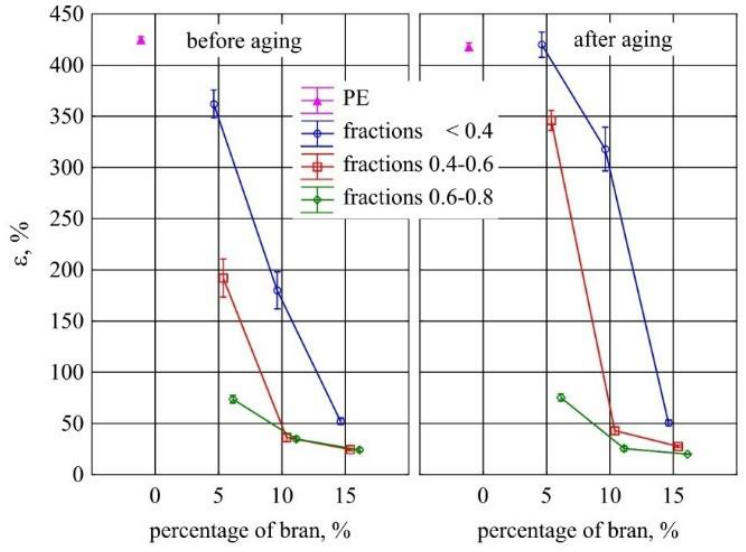
Figure 23. Elongation at break of injection mouldings before and after aging depending on the mass content and grain size of the introduced bran fraction (average values with standard deviation).